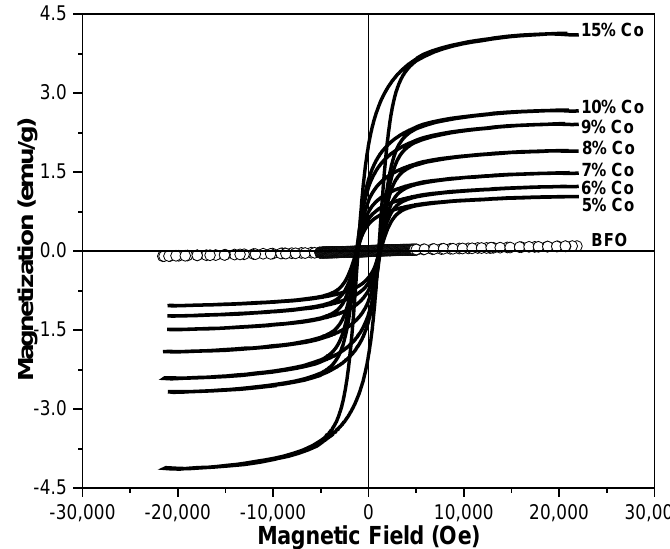
powders synthesized at different levels of BiFeO 3